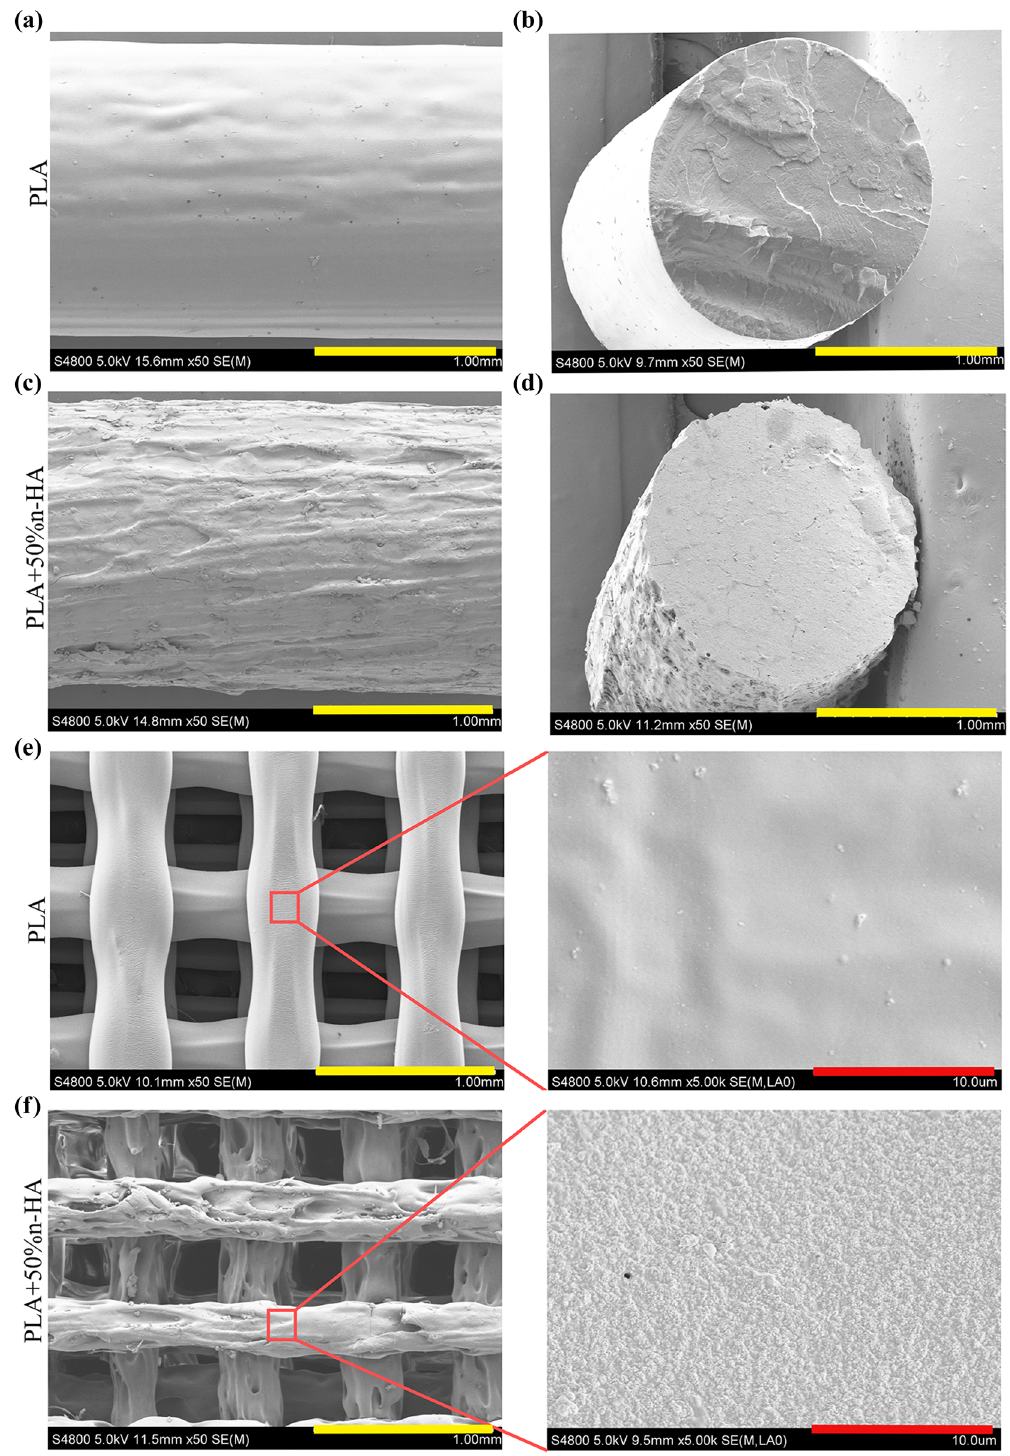
Figure 4: Filaments and 3D printed sca ff olds under SEM. SEM images of the surface ( a ) and the cross section ( b ) of PLA fi lament; SEM images of the surface ( c ) and the cross section ( d ) of PLA/n - HA composite fi lament; ( e ) SEM image of 3D printed PLA sca ff olds and its magni fi cation image ( right ) ; and ( f ) SEM image of 3D printed PLA/n - HA composite sca ff olds and its magni fi cation image ( right ) ( bars, yellow = 1 mm; red = 10 μ m )